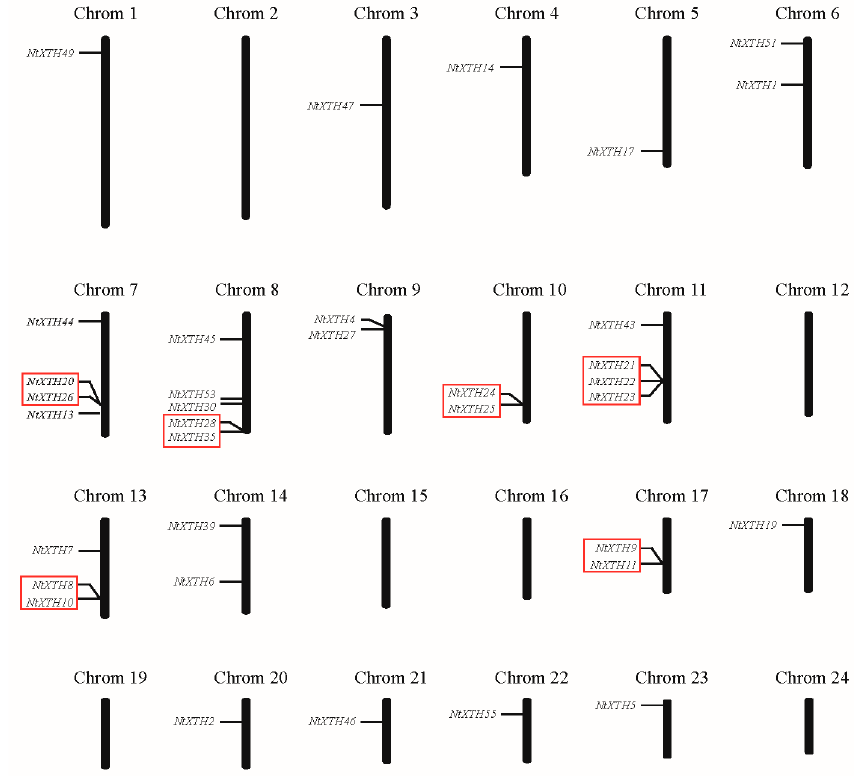
Figure 2. Distribution of NtXTH genes in common tobacco chromosomes. Red rectangles represent the putative tandem duplicate genes. putative tandem duplicate